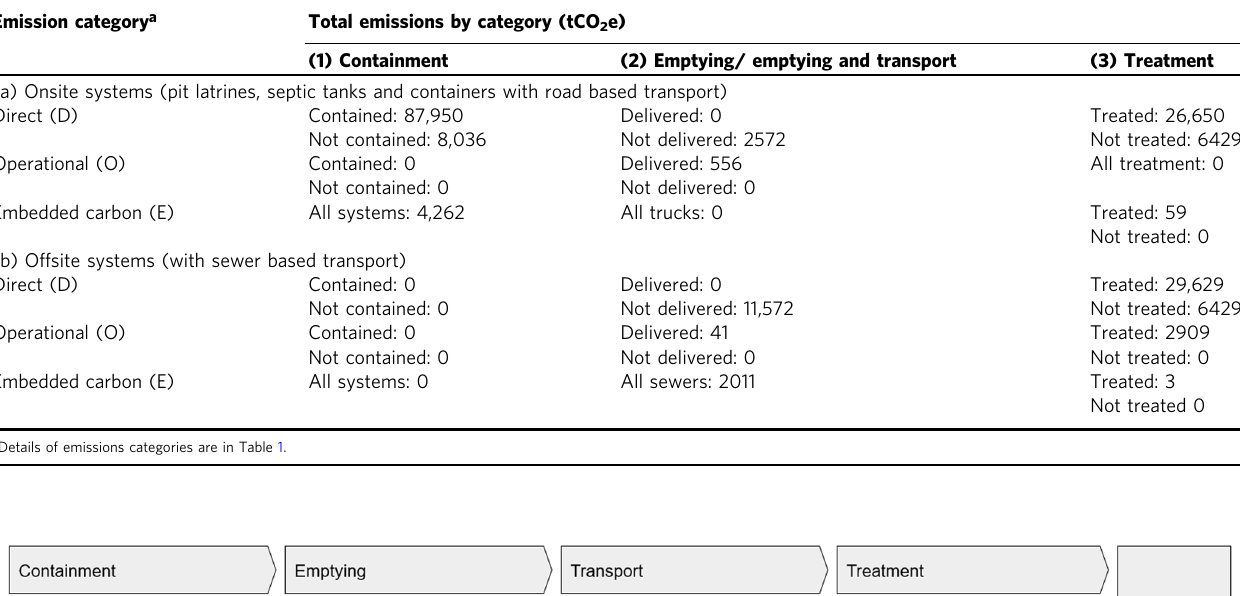
Table 5 Principal sources of greenhouse gas emissions from whole-chain sanitation systems (a) onsite systems, (b) offsite systems in Kampala.